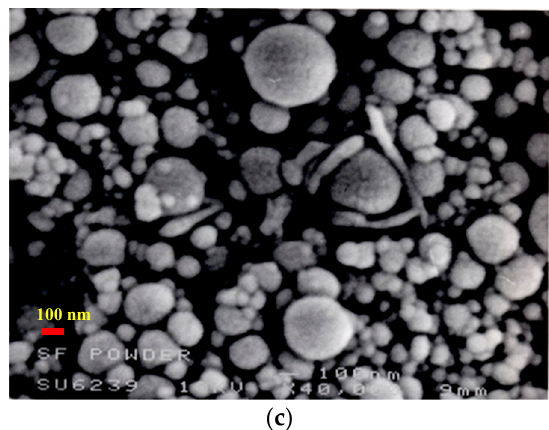
Figure 2. Back-scattered electron detector images of fine powders. ( a ) PC; ( b ) PFA; ( c ) SF. Table 1. Proportions of Portland cement (PC), pulverized fuel ash (PFA) and silica fume (SF) of the developed mixtures. No. of